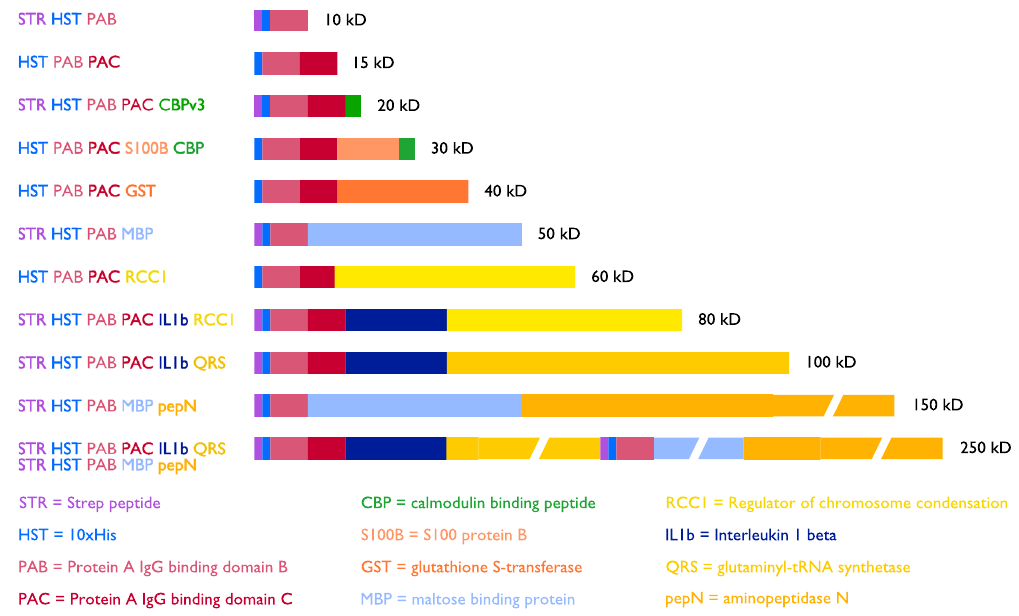
Figure 1. Schematic representation of Penn State ladder proteins with abbreviation key and color coding